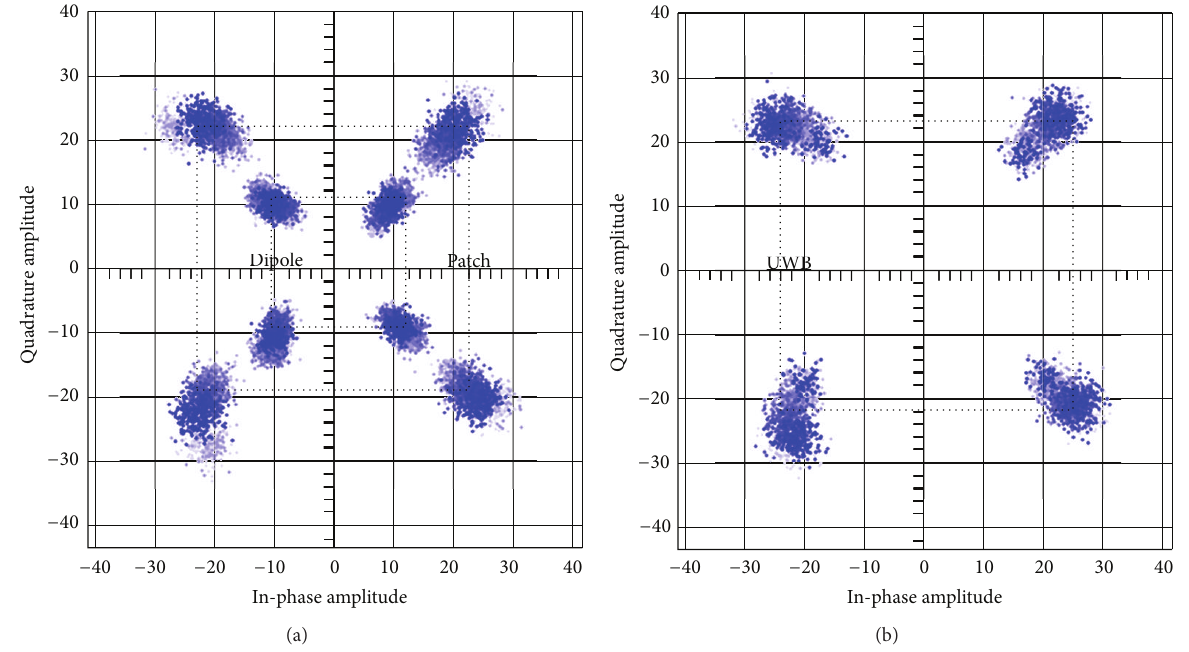
Figure 6: QPSK constellation diagrams related to a SDR platform operating at 5.8 GHz band and using (a) the Dipole (inner) or the Patch (outer) antenna and (b) the designed UWB